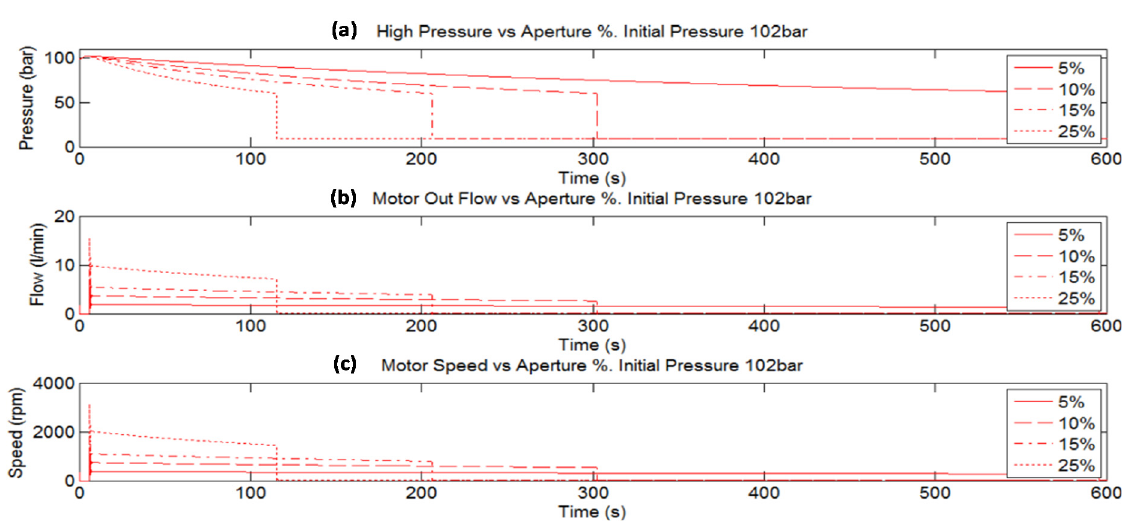
Figure 19. HP accumulator pressure evolution in bar ( a ). Hydraulic Motor Flow evolution in L/min ( b ). Hydraulic Motor Speed in rpm ( c ). Comparison between different control valve apertures when PTO input movement is